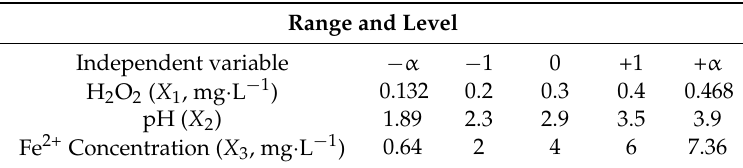
Table 1. Optimization of parameters, experimental range and level of independent variables, on photo-Fenton degradation of Tylosin.